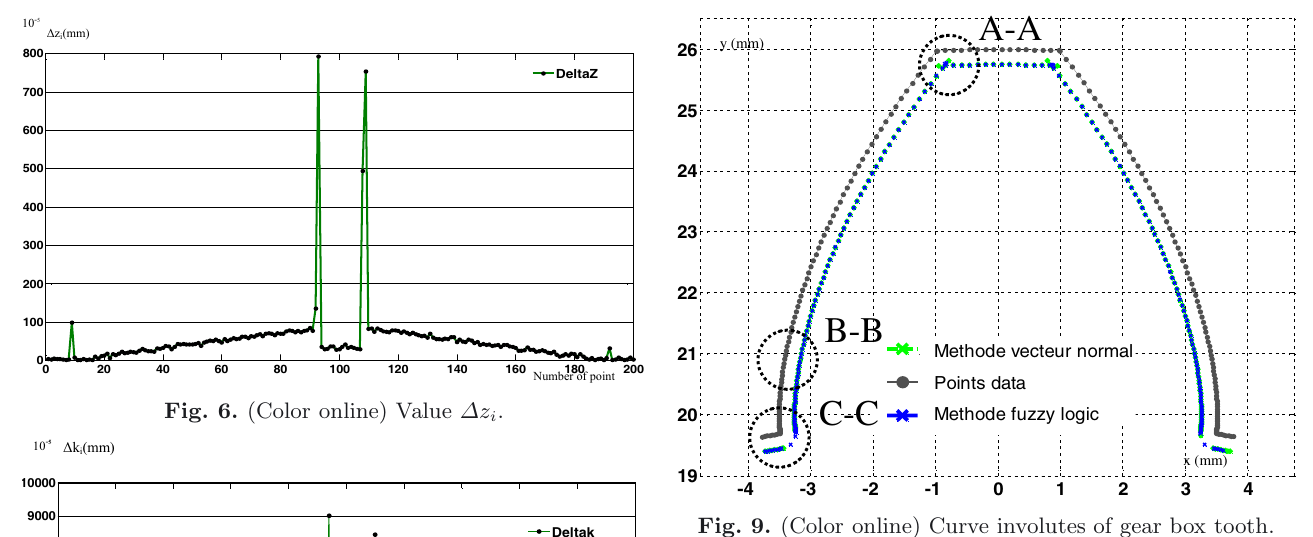
Fig. 9. (Color online) Curve involutes of gear box tooth.